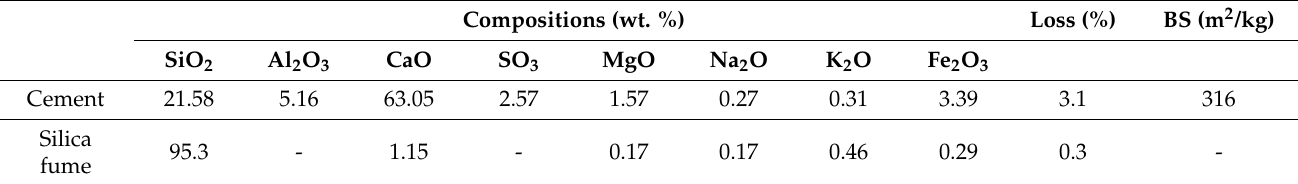
Table 1. Chemical composition and physical properties of the cement and silica fume.